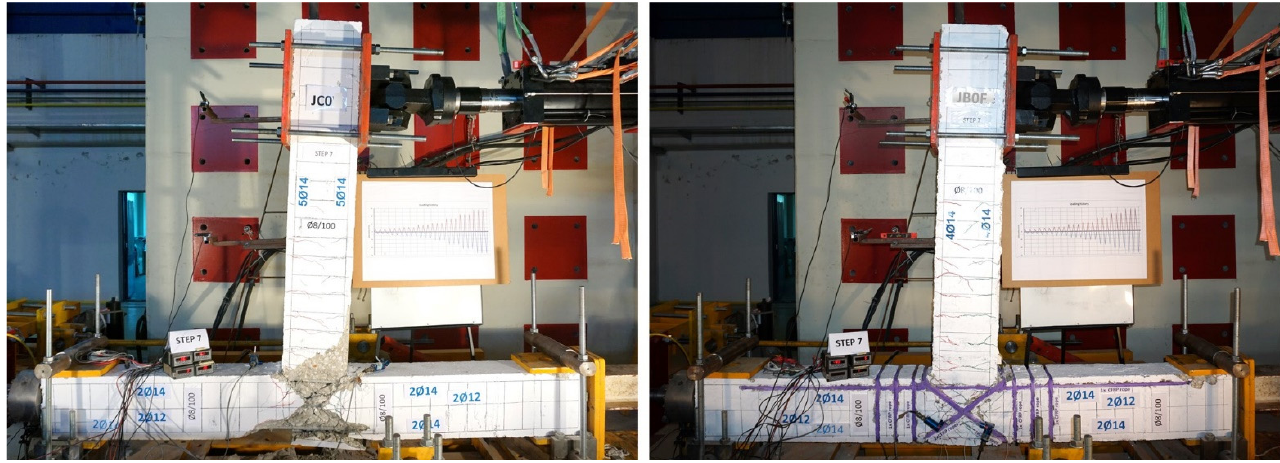
Figure 9. Comparative presentation of the damage of the two specimens after the test. In the case of the specimen JB0F the strengthening of the column and the joint body with C-FRP ropes kept the joint almost intact reducing the cracking.